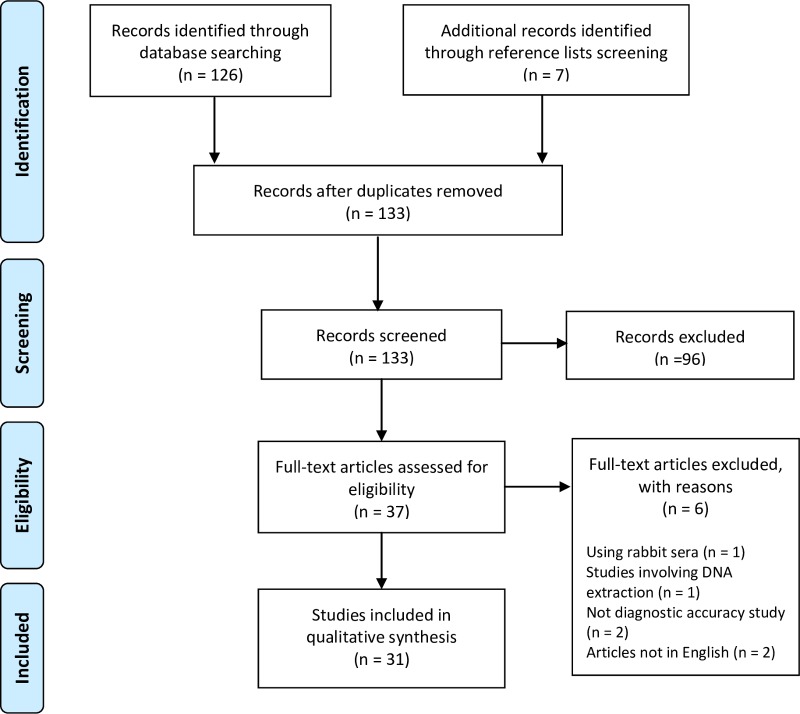
PRISMA flow diagram.